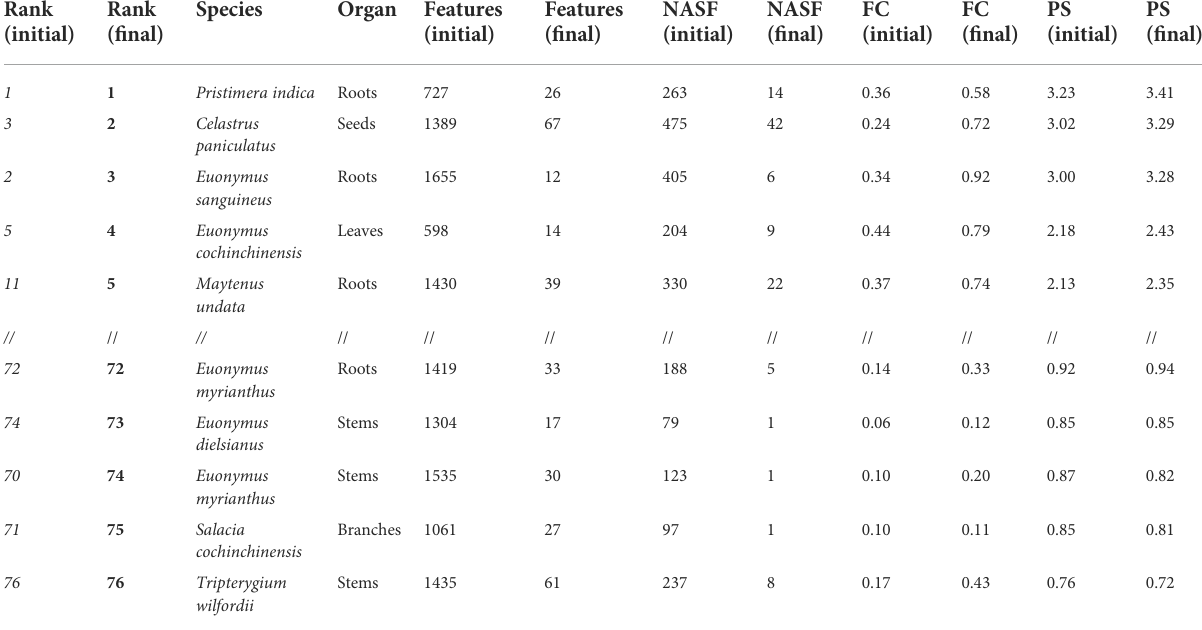
TABLE 2 Top and lowest fi ve extracts of the Celastraceae collection after application with and without fi lters of Inventa . initial : before fi ltering; fi nal , after fi ltering; NASF, unannotated speci fi c features; FC, Feature Component; PS, Priority Score. Rank Rank (initial) ( fi